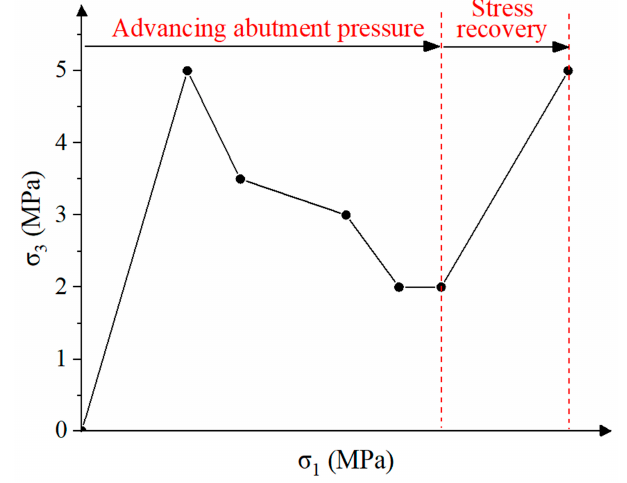
Figure 1. Stress state of surrounding rock under coal seam mining.